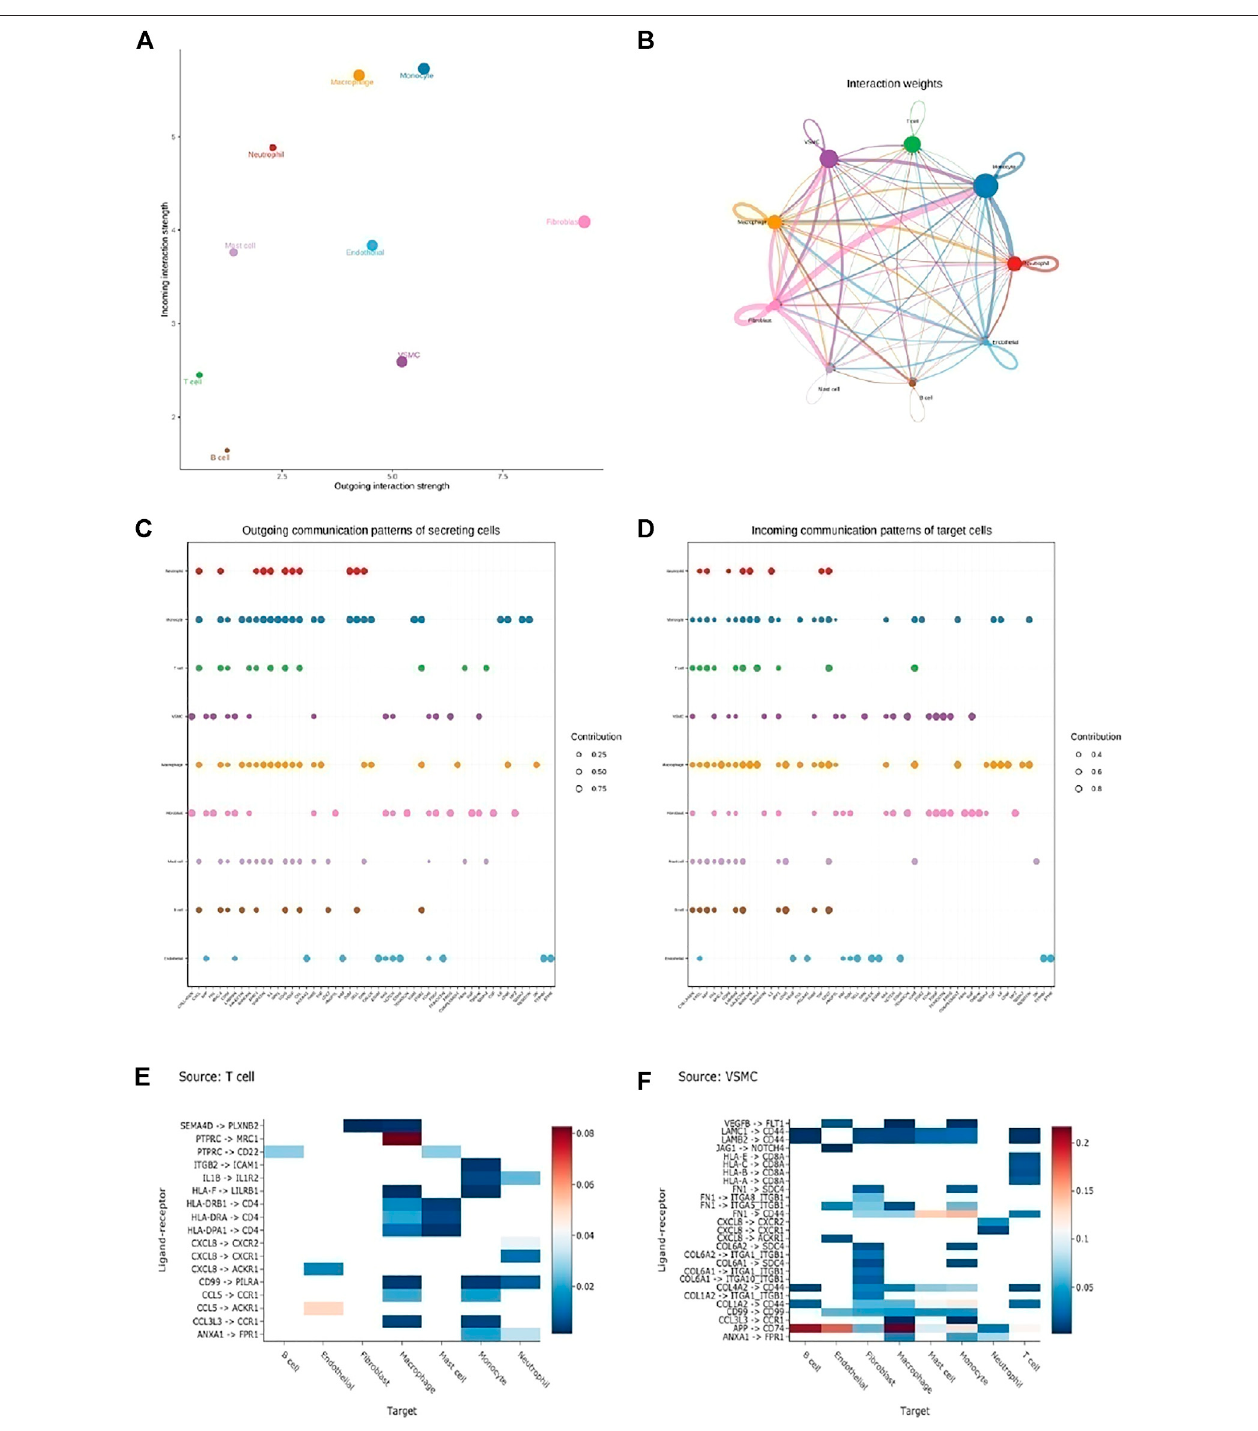
FIGURE 6 | Cell-cell ligand-receptor network analysis. (A) Comparison of total incoming path weights with total outgoing path weights among all cell populations. (B) Circularnetworkdiagramofimportantcell – cellinteractionpathways.Arrowandedgecolorrepresentdirection(ligandandreceptor),whileedgethicknessrepresents thesumofweightedpathsamongpopulations. (C) Thedotplotshowsthekeyligandsintheoutgoingsignalmodeofthesubsetofsecretorycells. (D) Thedotplotshows the key receptors in the incoming signal mode of the subset of receiver cells. (E – J) The weight of the interaction shown in the heatmap was calculated as the productofthemeanligandexpressionofthesourcecelltypes,includingTcells (E) ,SMC (F) , fi broblast (G) ,monocyte (H) ,macrophage (I) ,andendothelialcells (J) tothe mean receptor expression of target cell types. (unilateral Wilcoxon rank-sum test and Benjamini – Hochberg false detection rate [FDR] > 0.01).